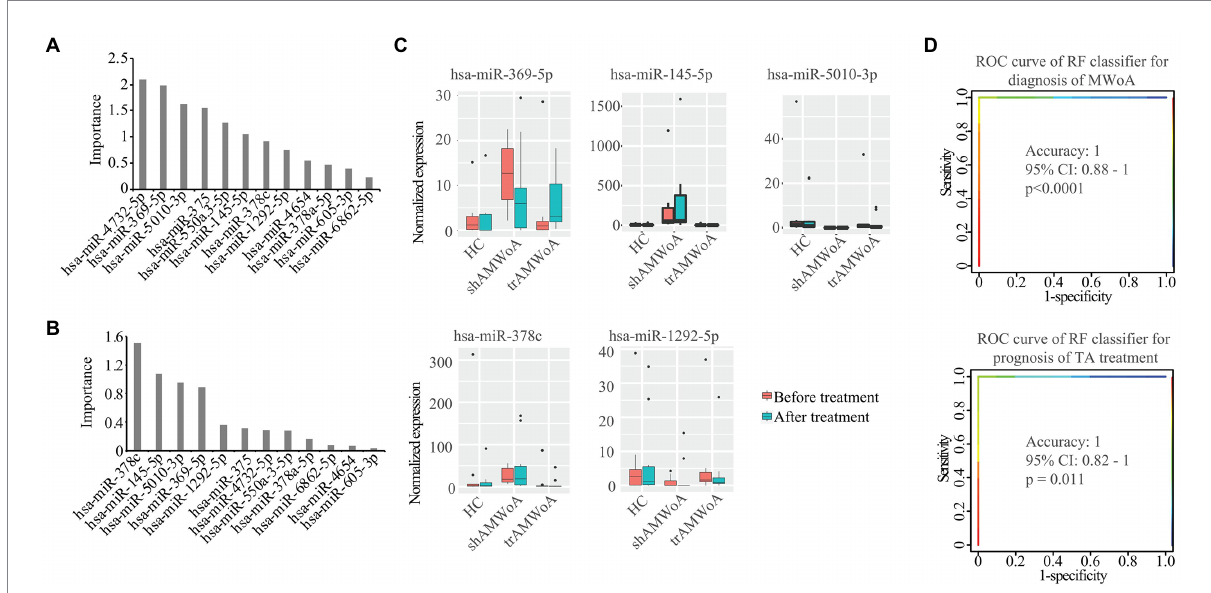
FIGURE 4 Potential diagnostic and prognostic biomarkers for MWoA patients. (A) The importance of these 12 miRNAs in separating MWoA patients and healthy controls. (B) The importance of these 12 miRNAs in predicting TA treatment for MWoA patients. (C) The changes in expression level of these 5 miRNAs after TA and SA treatment. (D) ROC curve of RF classifier for diagnosis of MWoA and ROC curve of RF classifier for prognosis of TA treatment. HC, healthy controls; trAMWoA, migraine without aura patients receiving true acupuncture treatment; shAMWoA, migraine without aura patients receiving sham acupuncture treatment; ROC curve, receiver operating characteristic curve; RF, random forest; TA, true acupuncture; MWoA, migraine without aura